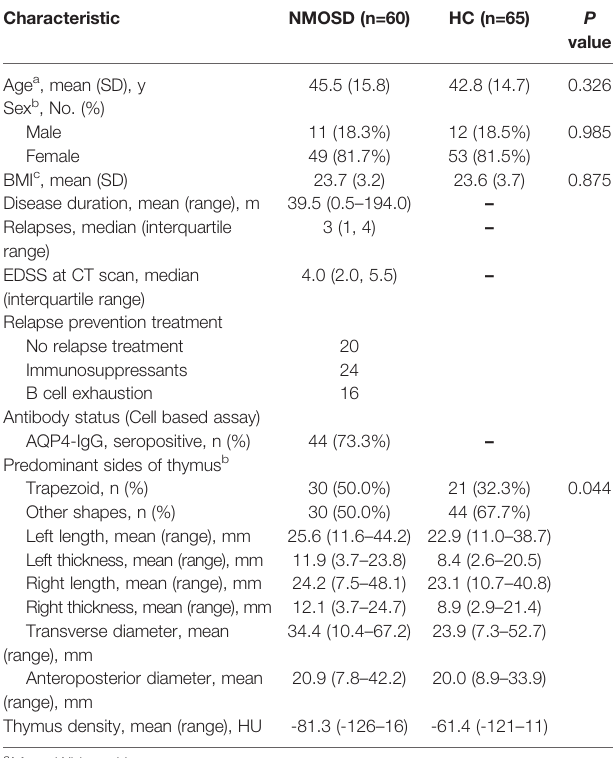
ordinal regressions were performed to examine the relationships of thymic predominant sides, volume, density, and thymic scores with age, sex, body mass index (BMI), and disease duration. For partial correlation coef fi cient, partial correlation analysis was performed after controlling for age or BMI.